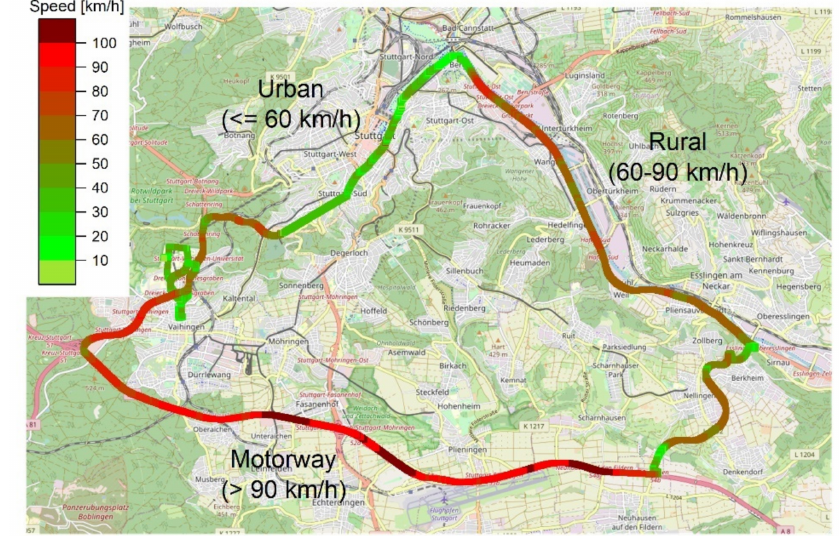
Figure 1. Overview of the selected real-world driving test route in the Stuttgart metropolitan area (and an exemplary vehicle speed profile).